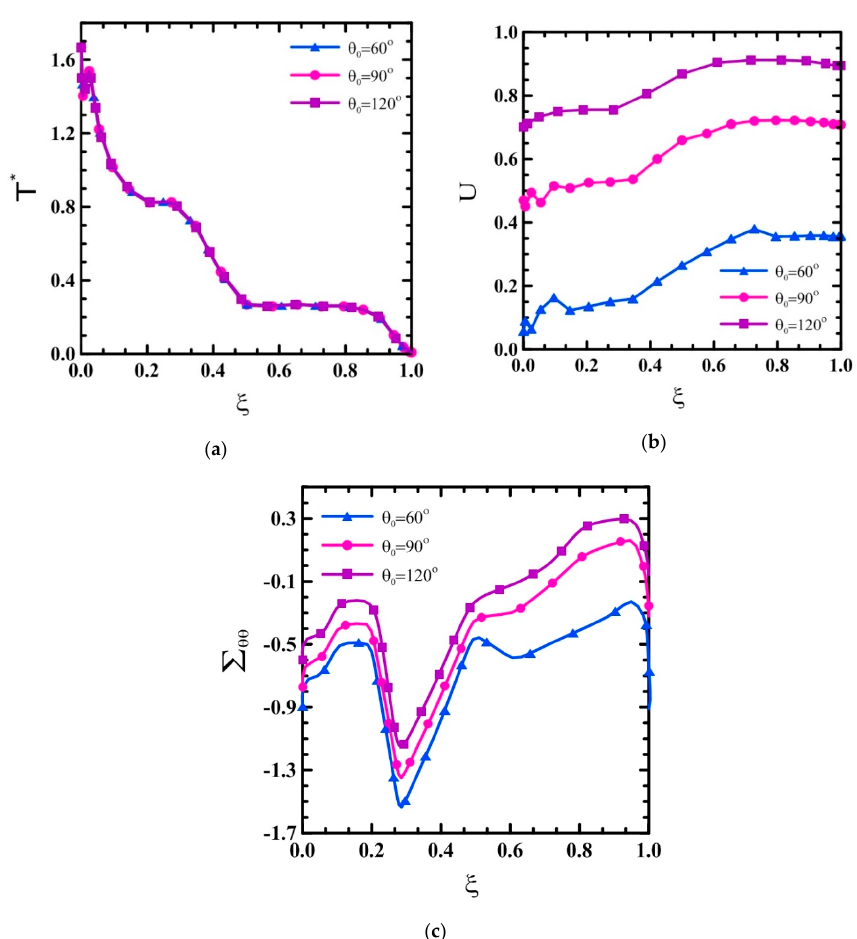
θ on the distribution of the thermoelastic field variables Figure 11. ( a – c ): Effect of the opening angle θ 0 on the distribution of the thermoelastic field variables in the